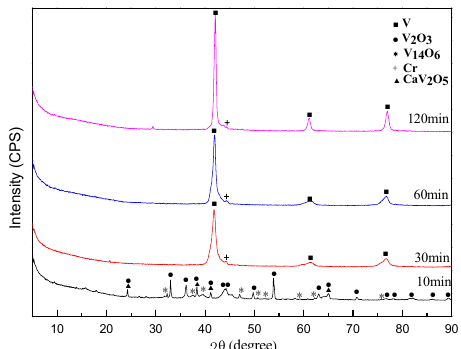
Figure 3. XRD patterns of the products electro-deoxidized in CaCl 2 –NaCl melt at different time.